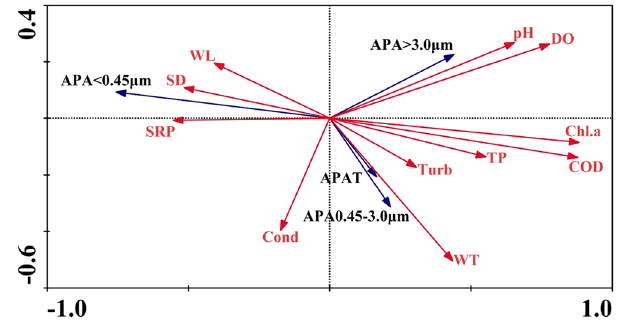
Figure 6. Biplot diagrams for RDA of the relationship between 11 environmental variables (red lines) and APA